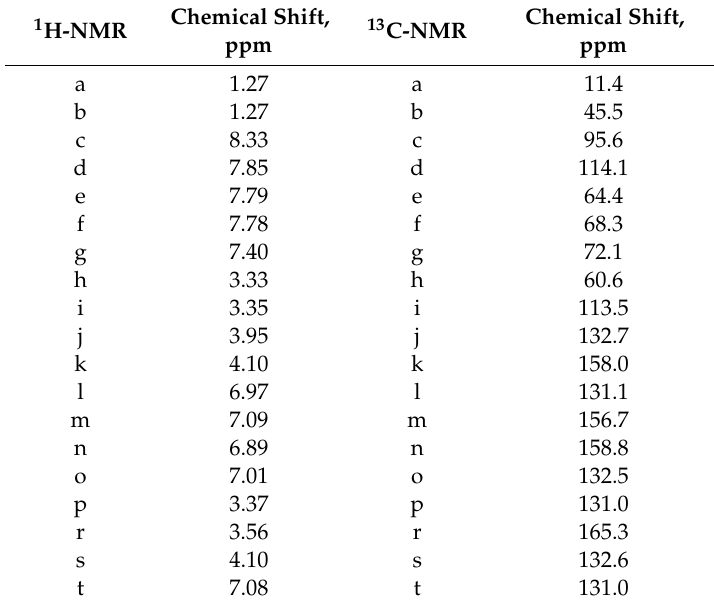
Table 1. NMR analysis of the rhodamine b derivative N -(9-(2-carboxyphenyl)-6-(diethylamino)- 3 H -xanthen-3-ylidene)- N -ethylethanaminium